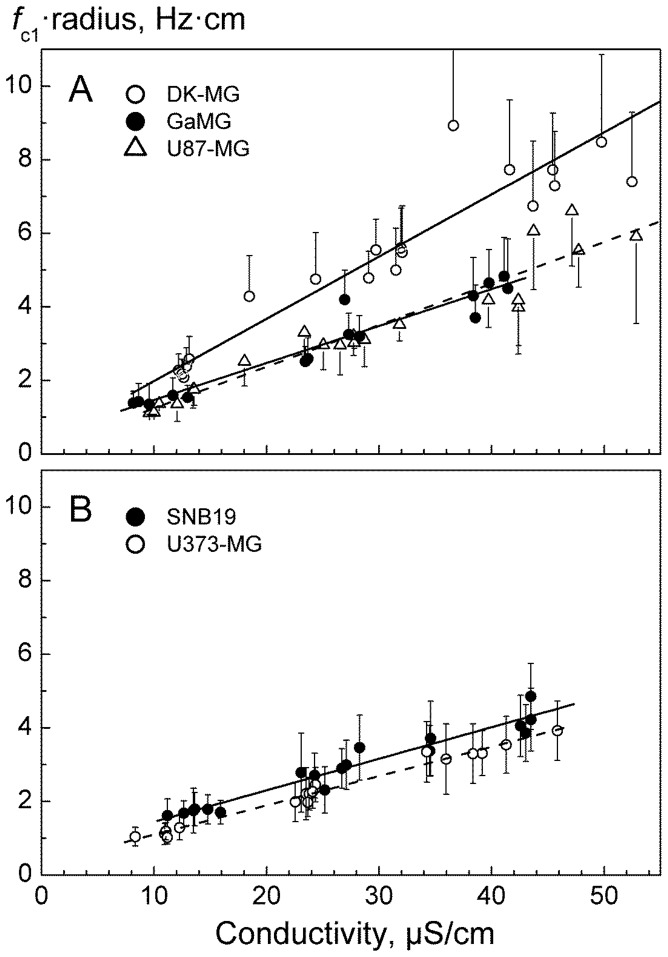
Cumulative plots of the radius-normalized f
c1 values (f
c1⋅a) of the indicated GBM lines versus the external conductivity σe.The measurements were performed in isotonic 300-mOsm inositol medium. The f
c1 data were obtained by the CRF-technique. Each symbol is the mean (±SE) from 20 cells measured at closely similar conductivities. The lines are best fits of Eq. 2 to the CRF data sets, each containing 300–420 cells. The line slopes are inversely proportional to C
m values. The steeper slope obtained for DK-MG cells implies a much smaller C
m = 1.9 µF/cm2 (A, empty circles), as compared to those of U373-MG (4.0 µF/cm2) and SNB19 cell lines (3.7 µF/cm2) (B). U87-MG and GaMG showed intermediate C
m values of 3.2 and 2.8 µF/cm2, respectively (A). The fitted C
m values are summarized in Table 1.